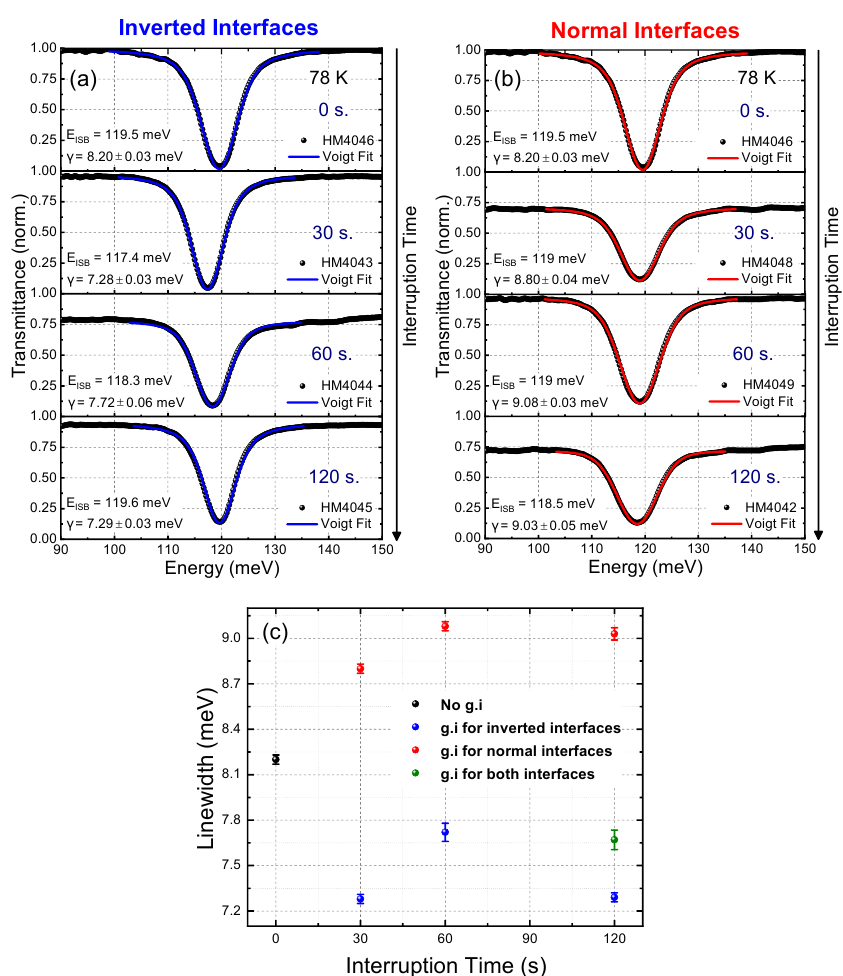
Figure 3. ( a ) ISB transmission spectra of the samples where the growth interruption was applied on the inverted interfaces (0, 30, 60, and 120 s.). ( b ) ISB transmission spectra of the samples, where the growth interruption was applied on the normal interfaces (0, 30, 60, and 120 s.). ( c ) The dependence of the ISBT linewidth on the growth interruption